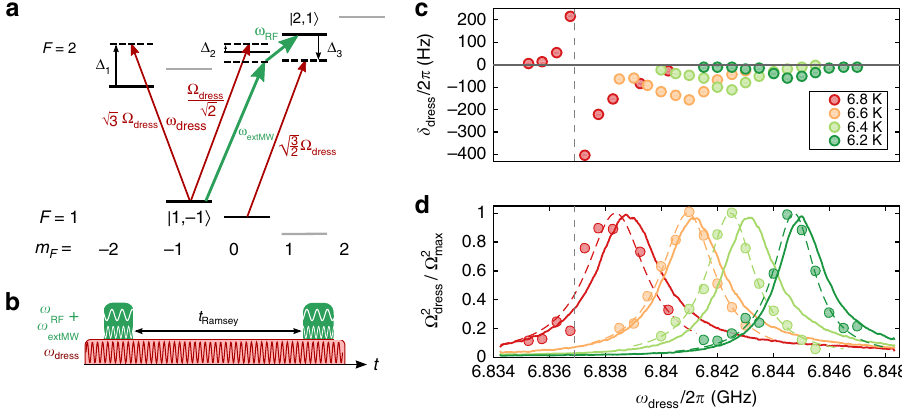
Fig. 2 Probing the off-resonant cavity fi eld with cold atoms. a Level scheme of the 87 Rb ground-state manifold. The external MW and RF frequencies used for driving the two-photon transitions for the Ramsey scheme (green) and the off-resonant coupling of the cavity fi eld to the relevant states are shown (red). b Experimental timing for the Ramsey sequence. The cavity fi eld (red) is driven throughout the interferometric sequence. c Measured shift of the Ramsey frequency vs. frequency of the fi eld in the superconducting microwave resonator for different chip temperatures. The sign change in the 6.8 K curve occurs at crossing the | 1, 0 〉 → | 2, 1 〉 transition, i.e., when Δ 3 = 0, as indicated by dashed vertical line. d Data points: Calculated microwave intensity Ω 2 based on the measurements of δ dress . The colored dashed lines are Lorentzian fi ts to the data points. The solid lines are the measured transmission dress spectra of the microwave